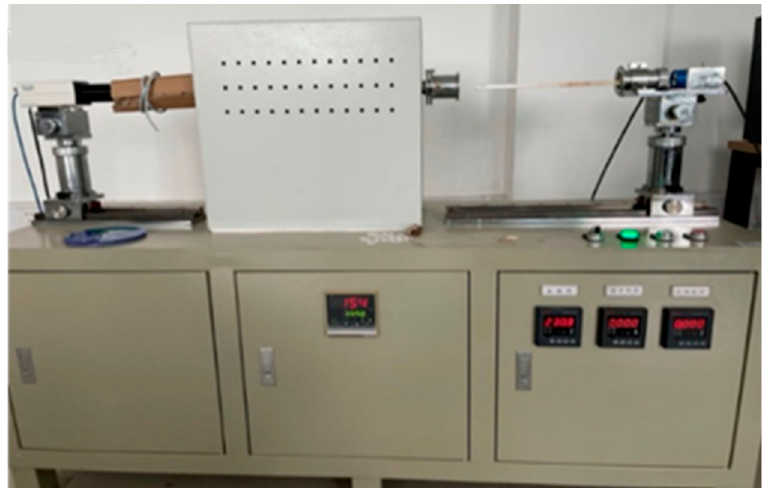
Figure 2. Test facility for determination of slag melting behavior.